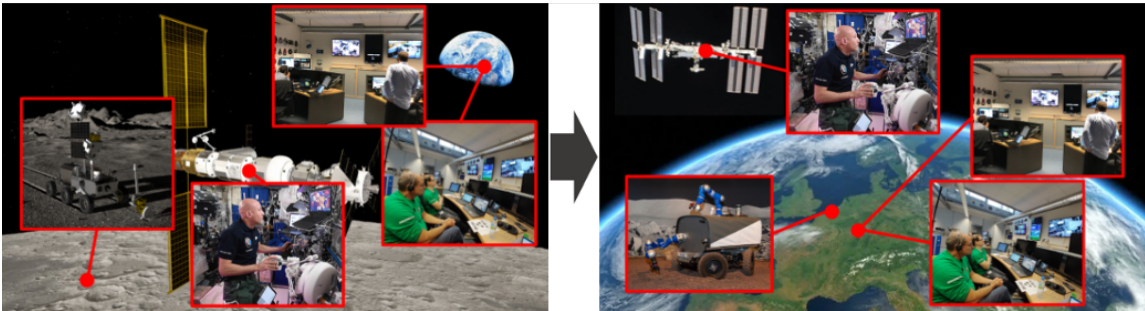
Figure 1. The ANALOG-1 analogue scenario